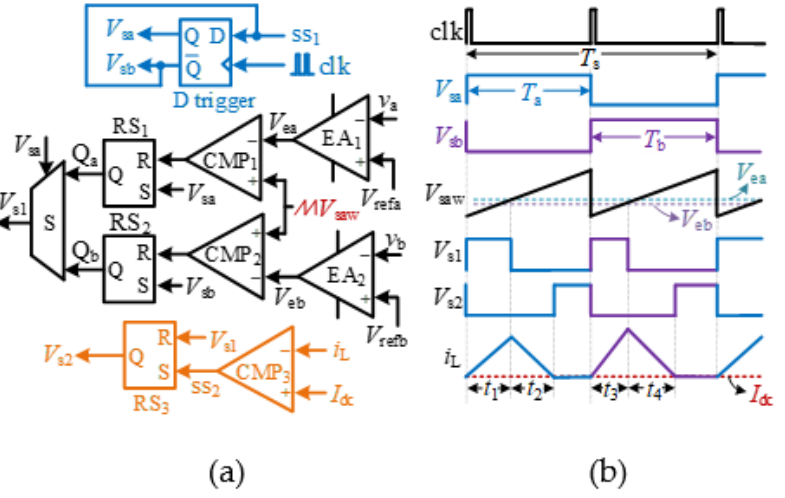
Figure 4. Conventional voltage mode-controlled PCCM SIDO buck converter: ( a ) control block diagram; ( b ) operation waveforms.